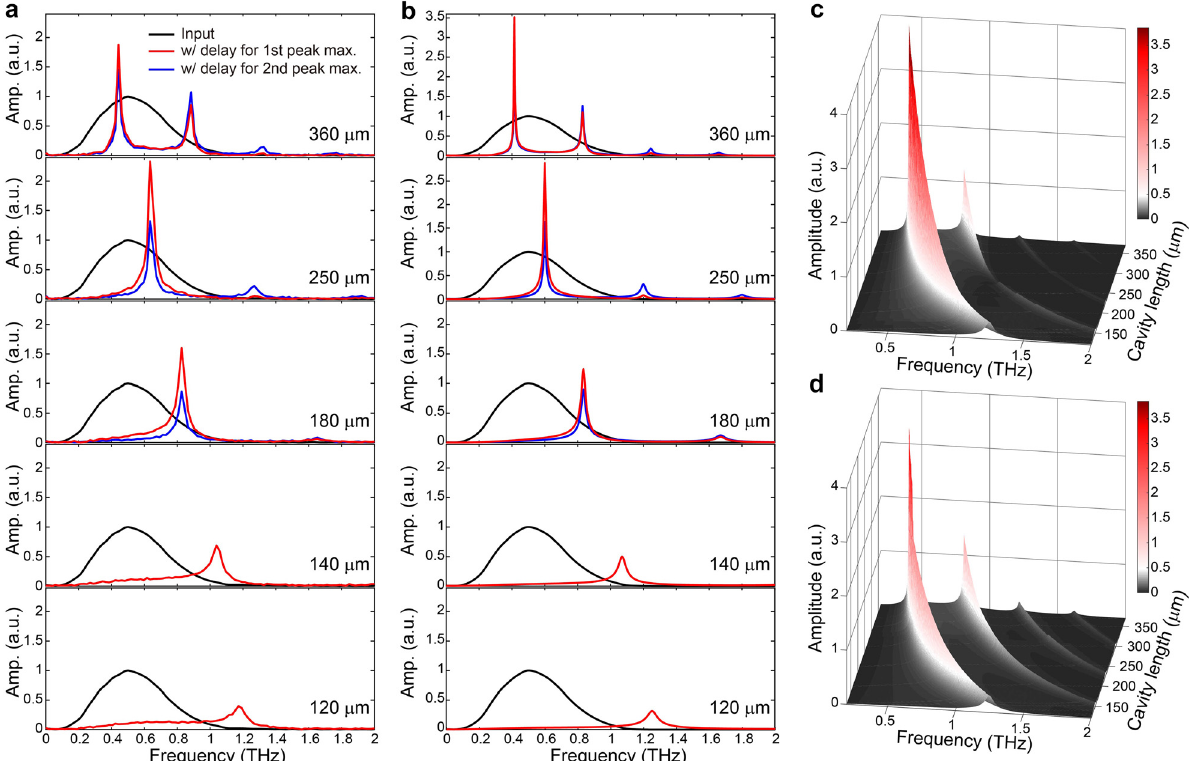
Figure 3: Measured and calculated spectral amplitudes for FP resonators with different cavity lengths. (a) Measured spectral amplitudes transmitted through the FP resonatorwith different cavity lengths(from the top panel, 360 μ m, 250 μ m, 180 μ m, 140 μ m, and 120 μ m). In each panel,measuredspectralamplitudesoptimizedforthefundamental(redlines)andsecond-order(bluelines)spectralcomponentsareplotted alongwiththespectralamplitudeoftheinputTHzpulse(blacklines).Inthesemeasurements,asingle-cycleinputpulseislaunchedintotheFP resonator. (b) Calculated spectral amplitudes transmitted through the FP resonator with different cavity lengths (from the top panel, 360 μ m, 250 μ m, 180 μ m, 140 μ m, and 120 μ m). (c) Calculated map of spectral amplitudes with pump delays optimized for maximizing the component funneled to the fundamental resonance frequency. (d) Calculated map of spectral amplitudes with pump delays optimized for maximizing the component funneled to the second-order resonance